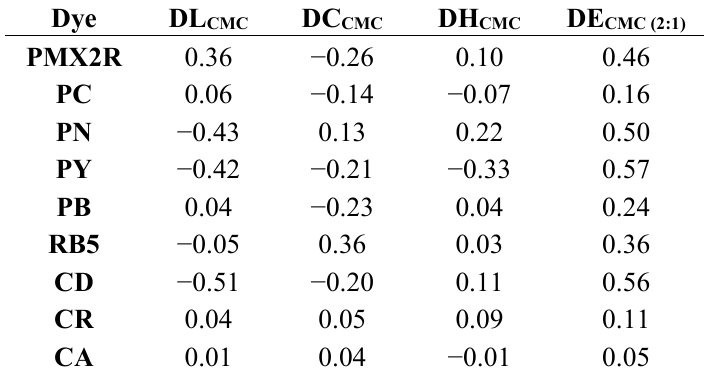
Table 3. Color differences: fabrics dyed with the treated and reused effluent vs. a reference dyeing.